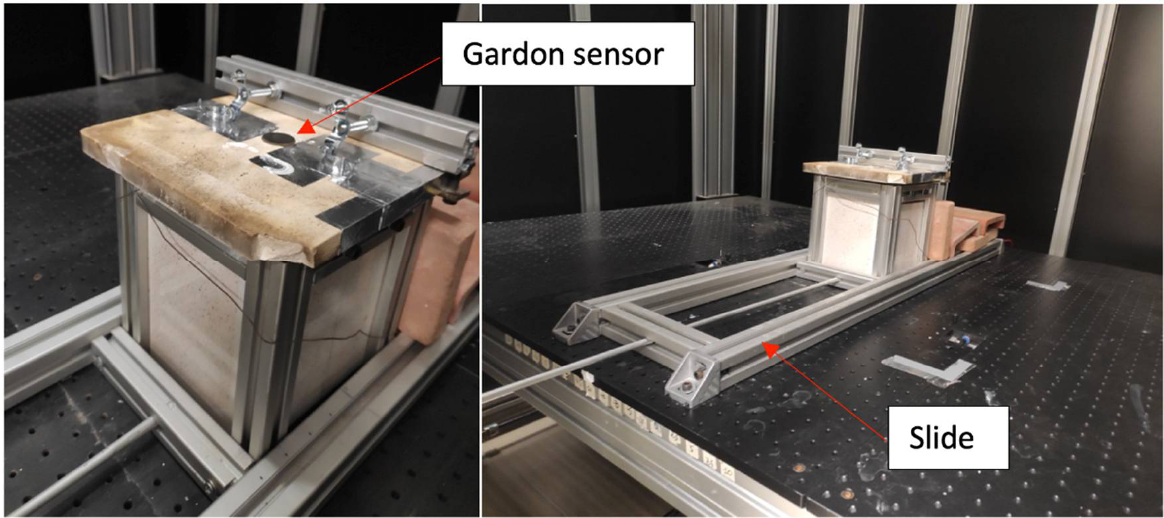
Figure 12. Pictures of the Gardon sensor mounted on the slide.